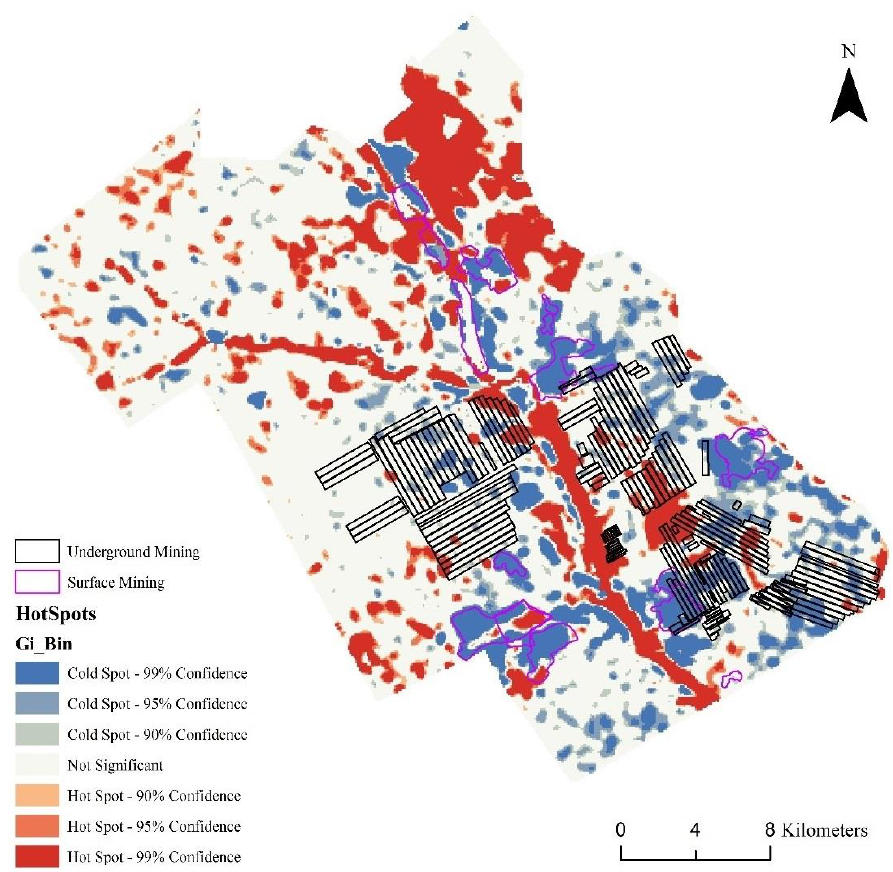
Figure 7. Cold and hot spot areas of changes in alpha diversity from 1990 to 2020.